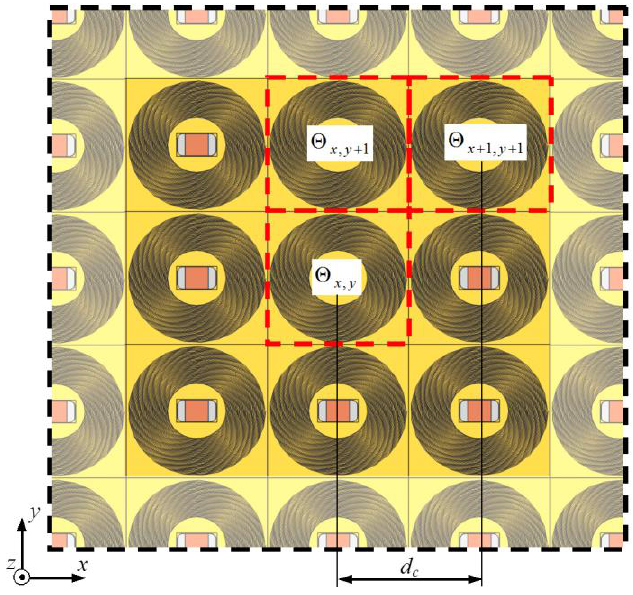
Figure 2. Transmitting / receiving surface of the periodic WPT system: Θ x,y —WPT cell, Θ x,y + 1 —adjacent WPT cell (by edge), Θ x + 1, y + 1 —adjacent WPT cell (by vertex).